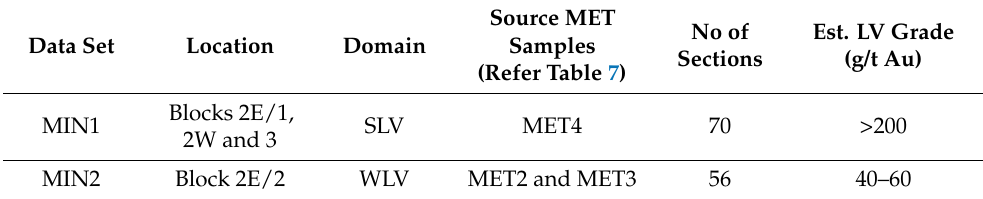
Table 6. Summary of mineralogical datasets used in this